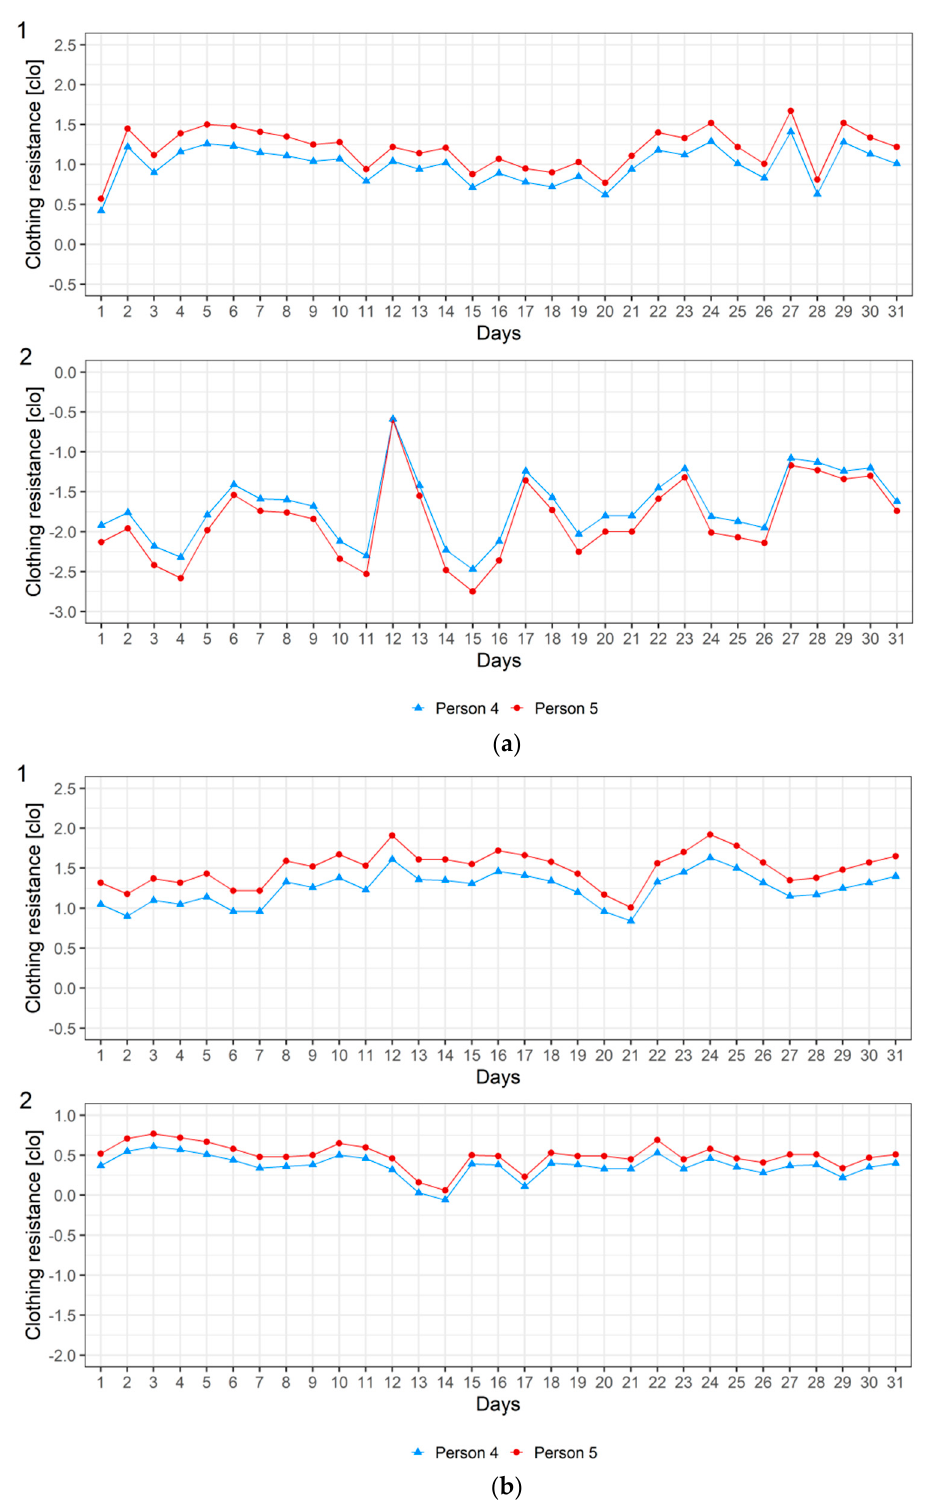
Figure 5. ( a ) Evolution of the thermal load at noon (12 UTC) for humans 4 and 5 over 31-day winter ( 1 ) and summer ( 2 ) season periods in the city of Szeged; ( b ) Evolution of the thermal load in the early morning (4–6 UTC) for humans 4 and 5 over 31-day winter ( 1 ) and summer ( 2 ) season periods in the city of Szeged.